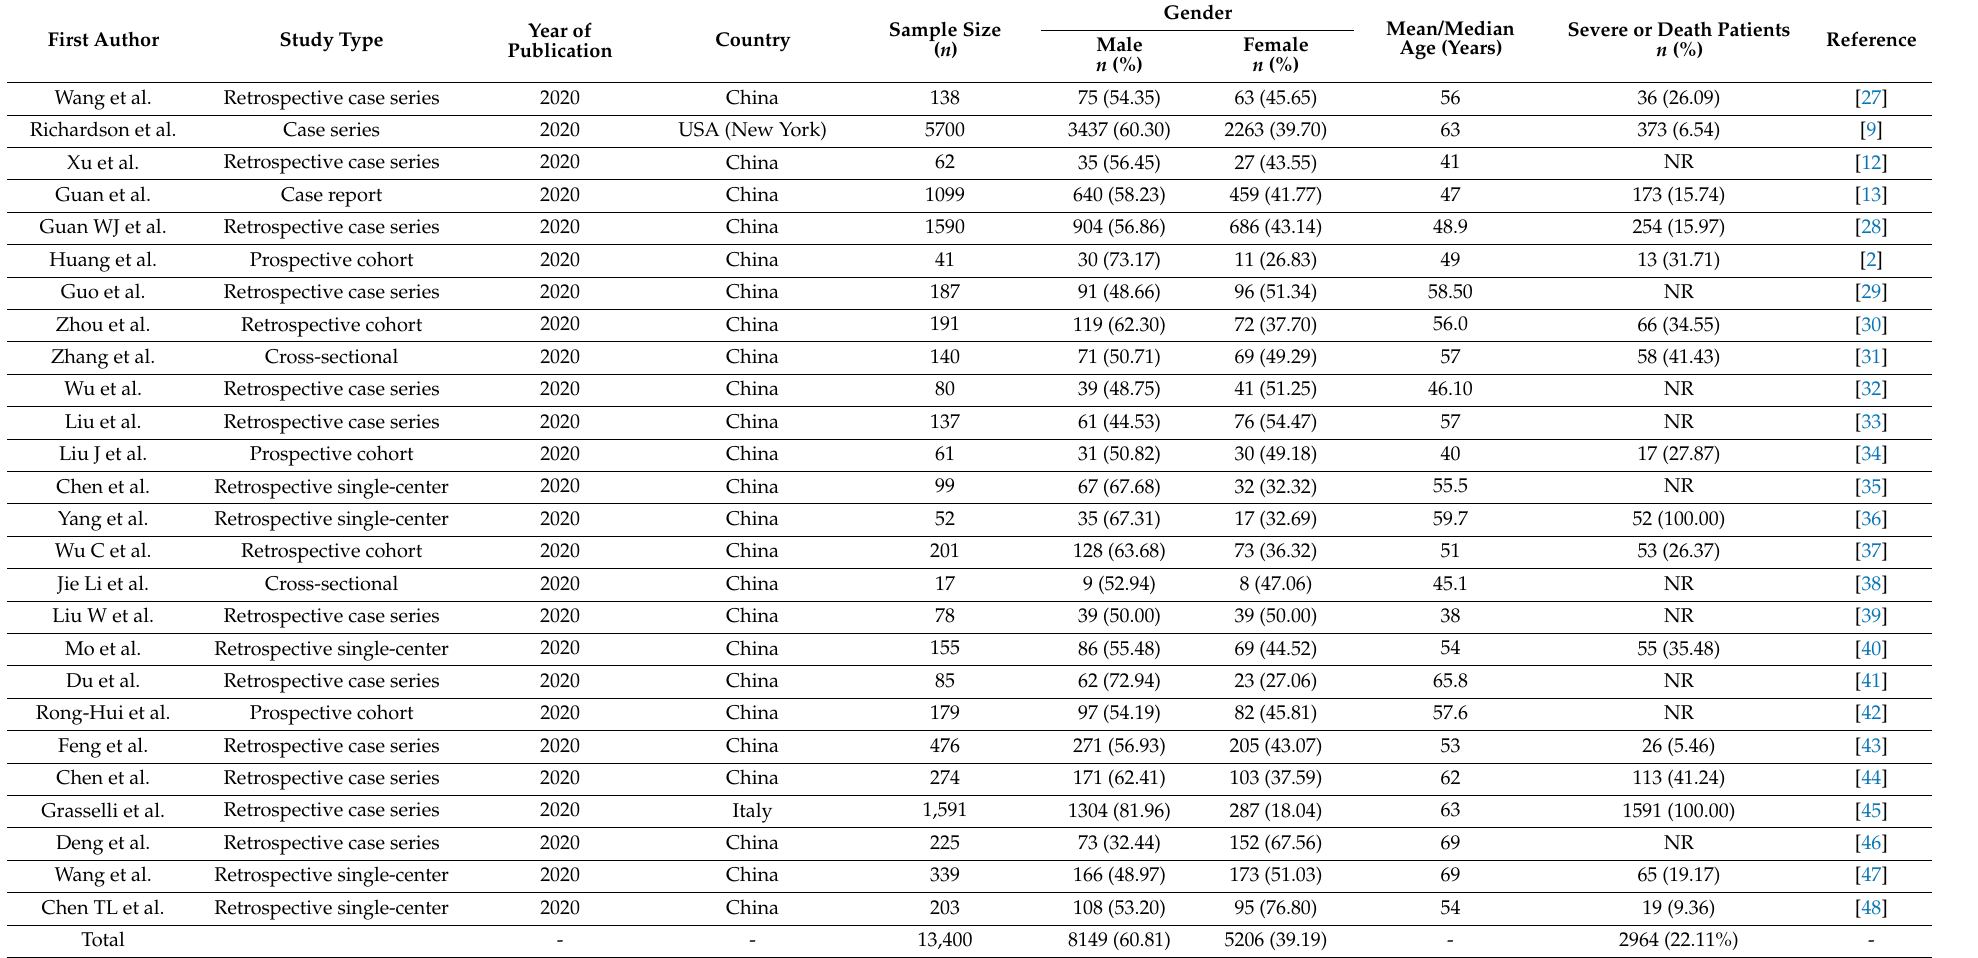
Table 1. Summary of study characteristics reported in the selected